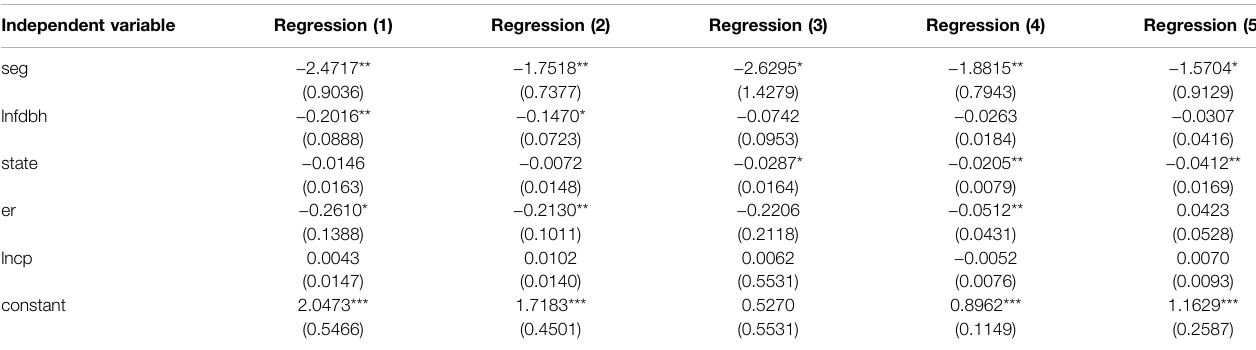
TABLE 8 | Robustness test and endogenous processing results.